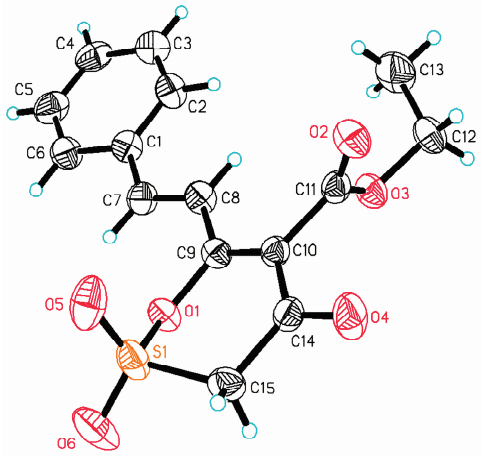
Figure 1. Crystal structure of S-CA